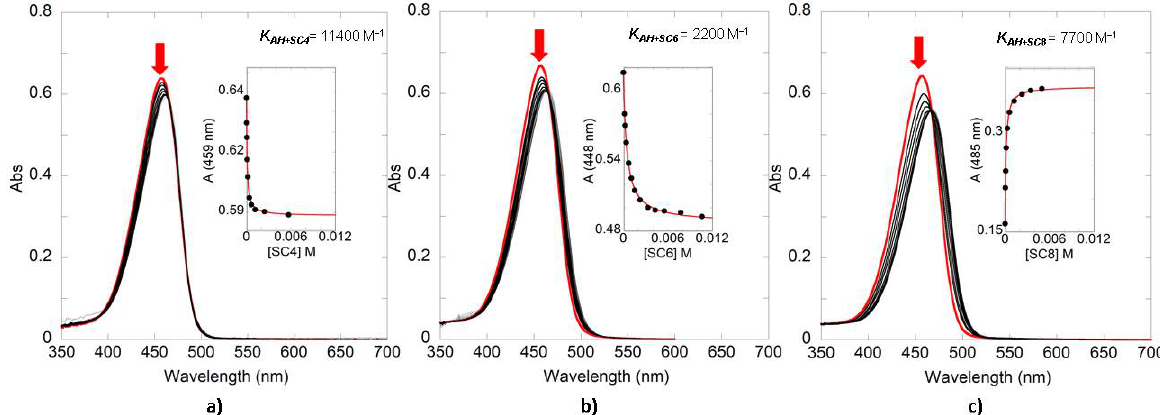
Figure 2. UV-Vis spectral variations of a 4′7-DHF (1.2 × 10 −5 M) solution at pH=1 upon addition of increasing concentrations of a) SC4, b) SC6 and c) SC8. The inset shows the fitting for the calculation of the association constant considering a 1:1 H-G interaction.